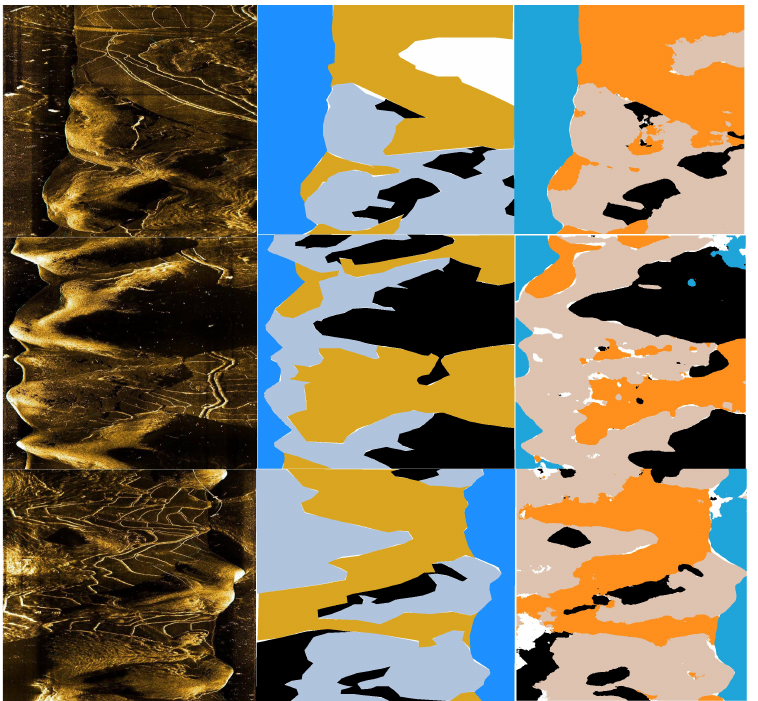
Figure 9. The segmentation results of the model output are shown in the figure. The original image, label, and output result are left to right. The colors in the picture are blue for water, gray for rocks, yellow for flat land, black for shadows, and white for fruitless areas (areas that are hard to